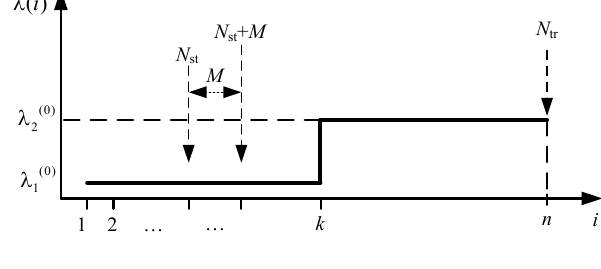
Fig. 1. The principle of sample size